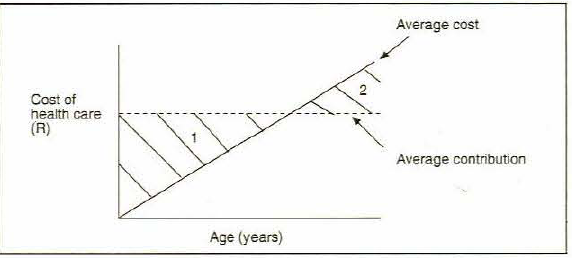
Fig. 1. Health core costs by age of member (before HIV/AIOSj. 1 ~ money received (by means of the average contribution) and not paid out in health COfE claims; 2 = money required (over and above the average contribution) to payhealth care claims.